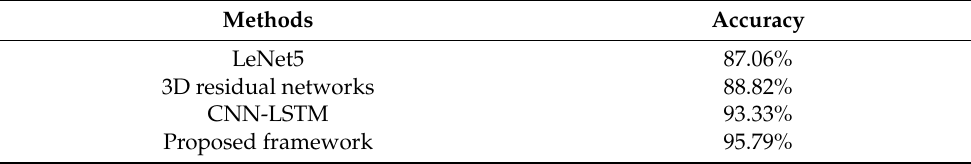
Table 4. Comparison of our method with other methods in our dataset.